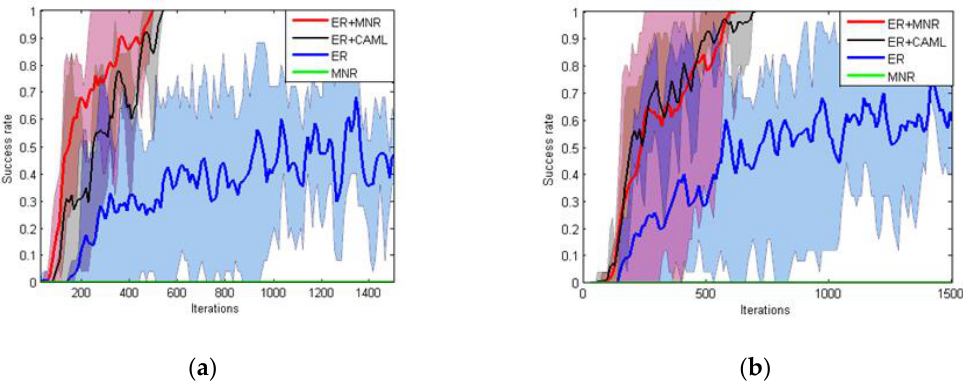
Figure 10. Success rate in training. ( a ) Success rate of the three methods in T-MAP 1 and ( b ) success rate of the three methods in T-MAP 2.